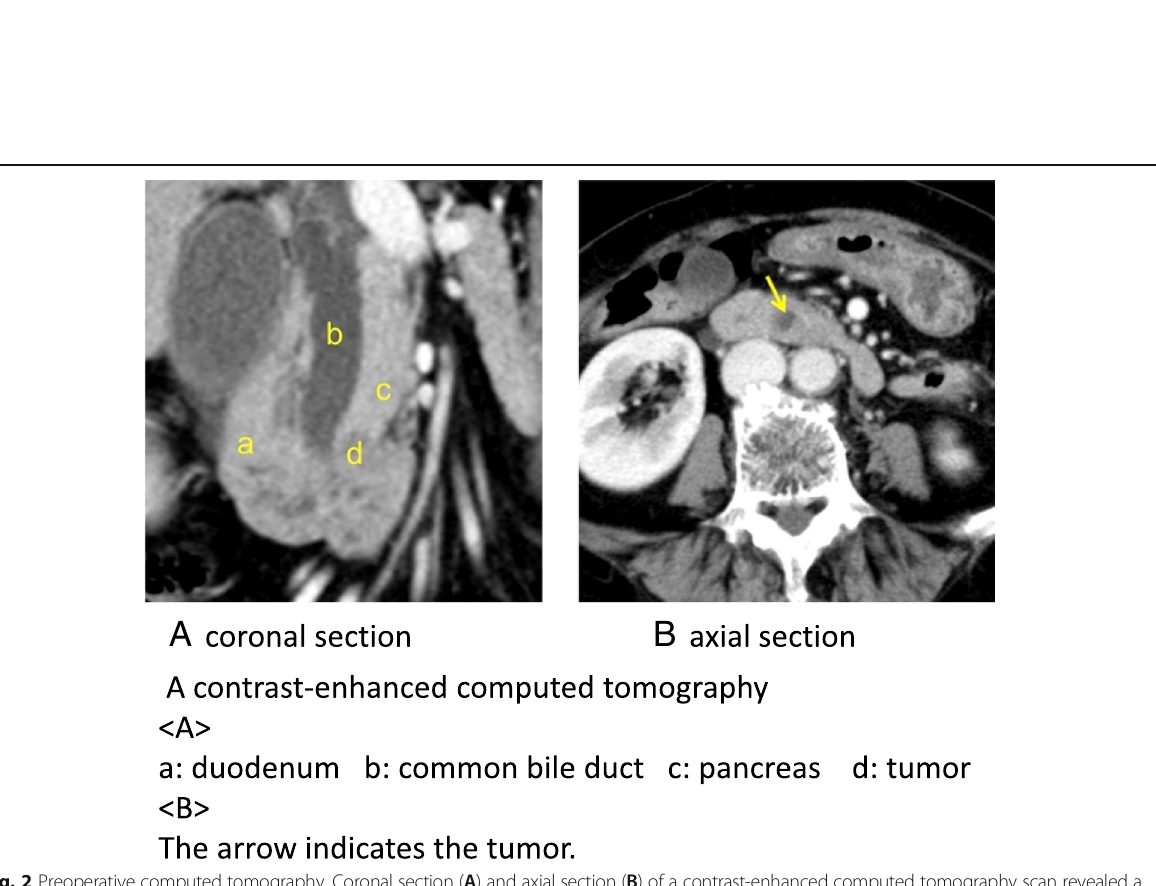
Fig. 2 Preoperative computed tomography. Coronal section ( A ) and axial section ( B ) of a contrast-enhanced computed tomography scan revealed a hypovascular tumor (arrows) at Vater ’ s papilla had invaded into the pancreas directly. a, duodenum; b, common bile duct; c, pancreas; d,